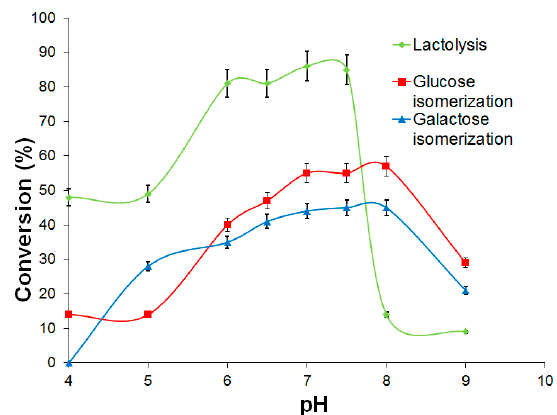
Figure 5. Lactolysis, glucose isomerization and galactose isomerization achieved by using the biocatalysts β -galactosidase, L -arabinose ( D -galactose) isomerase (LAI), and D -xylose ( D -glucose) isomerase (GI) immobilized onto Eupergit C (EC) sequentially at pH 4–9, during batchwise operation at 60 °C with 4.6% lactose as the starting substrate.